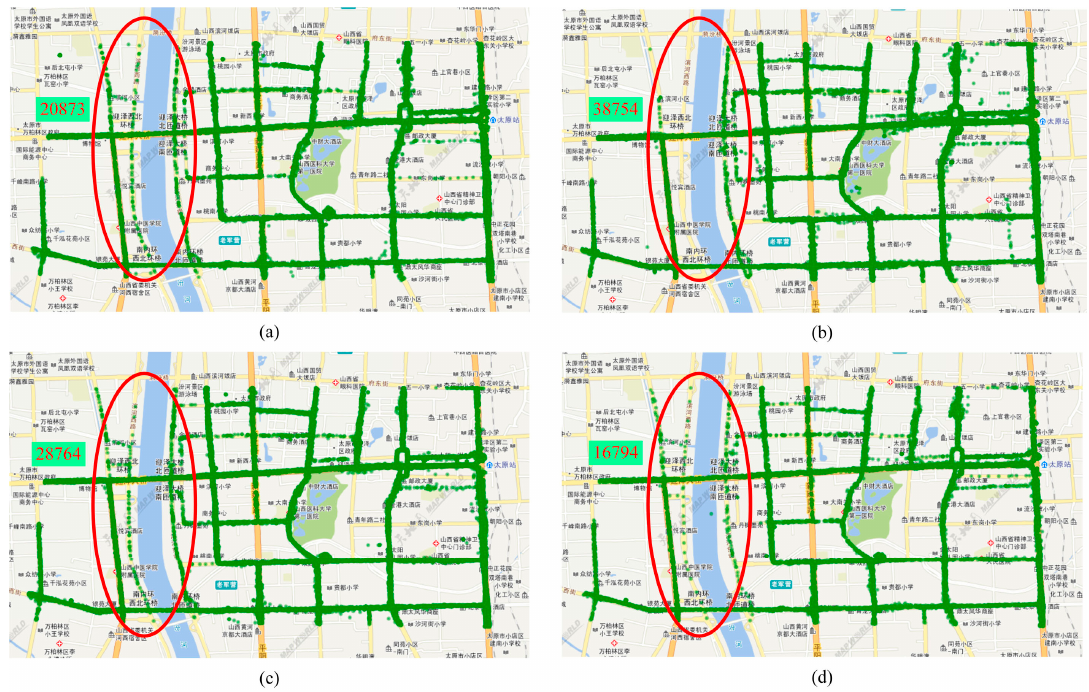
Figure 5. Retrieved BD bus locations in the Taiyuan national high tech Industrial Development Zone